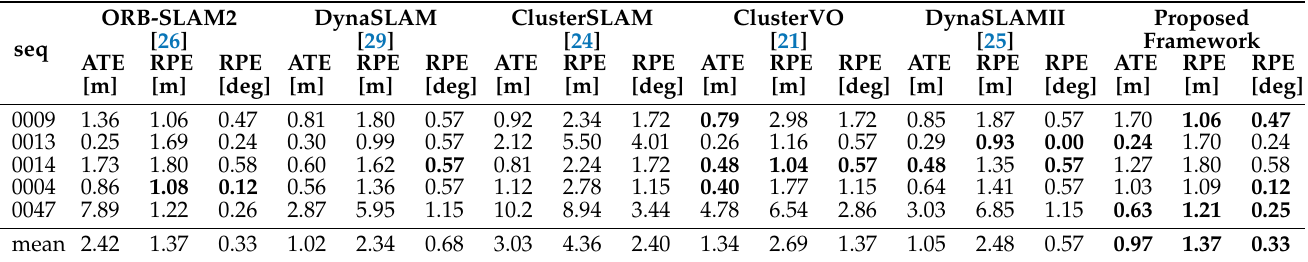
Table 2. The estimated trajectories evaluation and comparison on KITTI Raw DATASET.